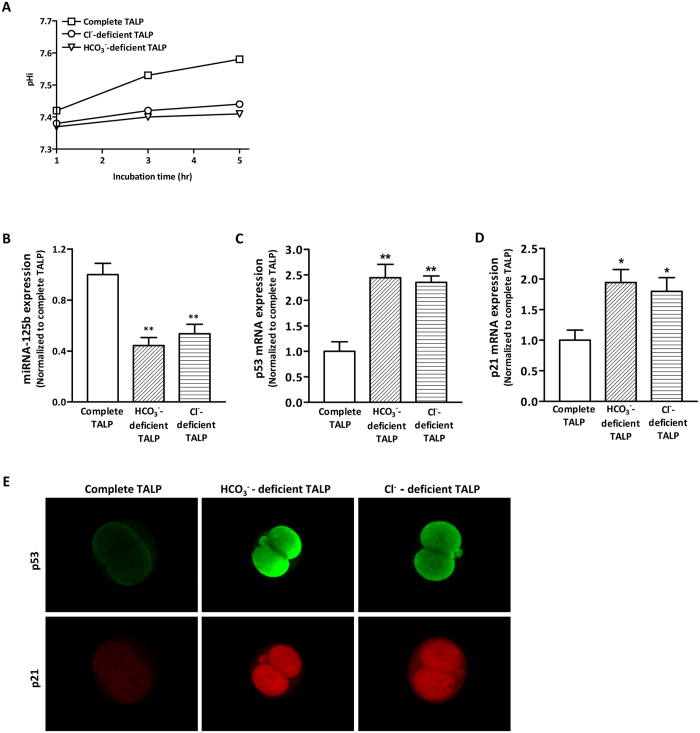
Involvement of Cl− in HCO3−-dependent signaling essential for embryo cleavage.(A) Intracellular pH measurement of 2-cell embryos incubated in Cl−-deficient, HCO3−-deficient or complete TALP medium. Five micromolar BCECF was loaded for 30 min before determination of the pHi. The time course changes in pHi were shown (10 embryos/group). The experiments were repeated 4 times. (B–D) Quantitative real-time PCR result showing the expression of miRNA-125b (B), p53 (C) and p21 (D) in embryos incubated in HCO3−-free or Cl−-free condition compared to that incubated in complete TALP medium. ** indicates P < 0.01 (by one-way ANOVA, ~100 embryos in each experiment, n = 4). (E) Representative immunofluorescence results showing increased expression of p53 (green) and p21 (red) in 0 mM HCO3− condition or 0 mM Cl− condition (5–10 embryos/group). Scale bar, 150 μm.